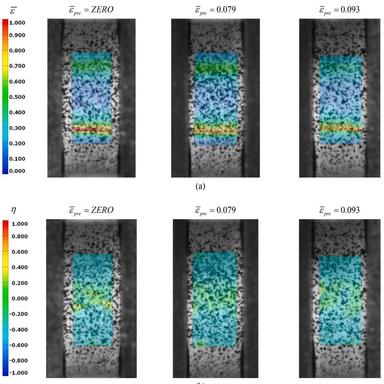
DIC analysis results just before compressive fracture for pre-tensile strained specimens: (a) the equivalent strain and (b) the stress triaxiality.